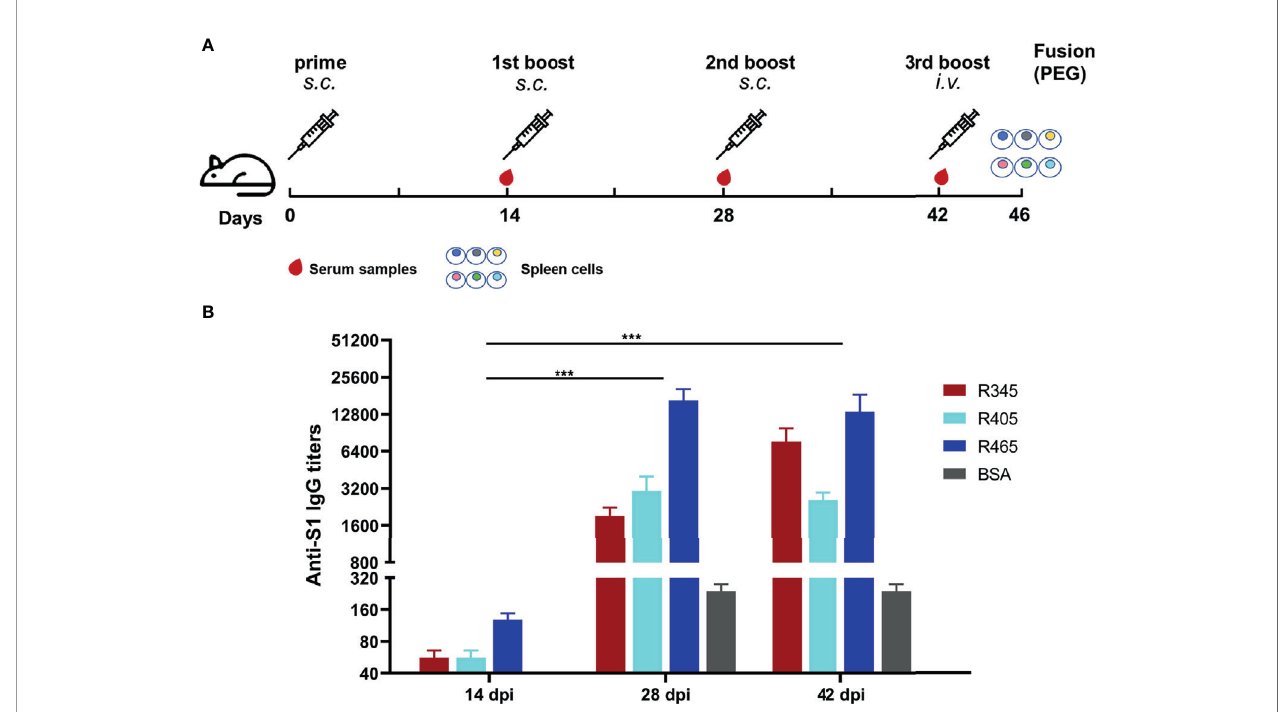
FIGURE 2 | Immunization strategies and antibody responses in mice. (A) Scheme of immunization and sampling. Serum samples were collected 2 weeks after each immunization. Each immunogen plus with Freund ’ s adjuvant by subcutaneous ( s.c. ) injection for the immunizations at 0, 14, and 28 dpi. The mice with the highest antibody titers in each group were given the 3rd boost by intravenous ( i.v. ) injection at 42 dpi for mAbs preparation. (B) Titers of serum samples at 14, 28, and 42 dpi were detected by ELISA. Data was shown as mean ± SEM. ***p < 0.001. Graphs were made in GraphPad Prism version